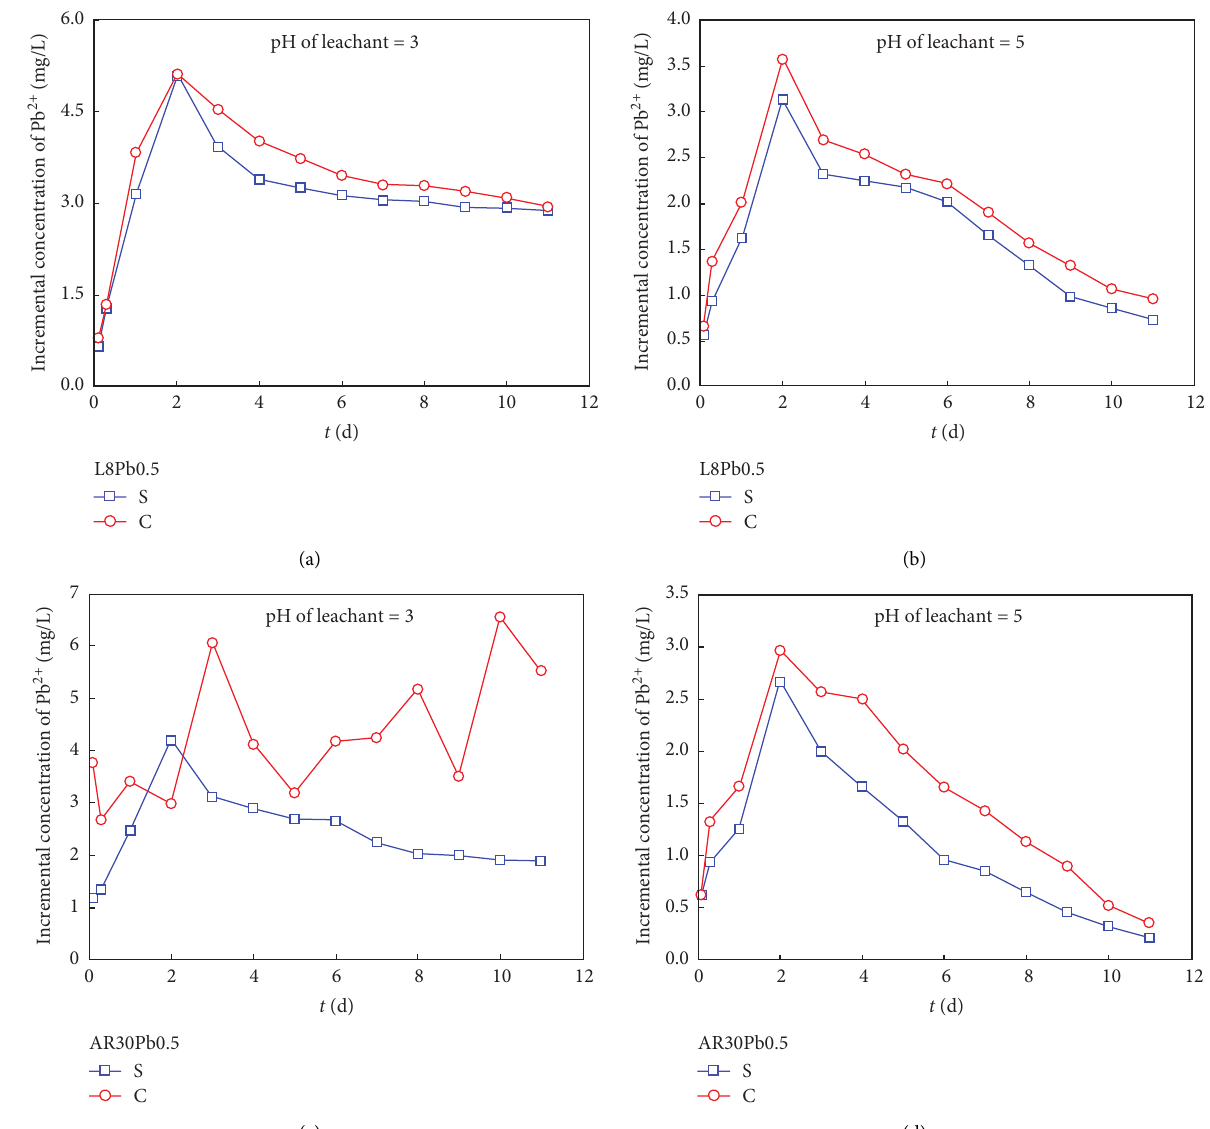
Figure 5: The evolution of incremental concentration of Pb 2+ in leachate with time: (a) L8Pb0.5, leachant pH of 3; (b) L8Pb0.5, leachant pH of 5; (c) AR30Pb0.5, leachant pH of 3; (d) AR30Pb0.5, leachant pH of